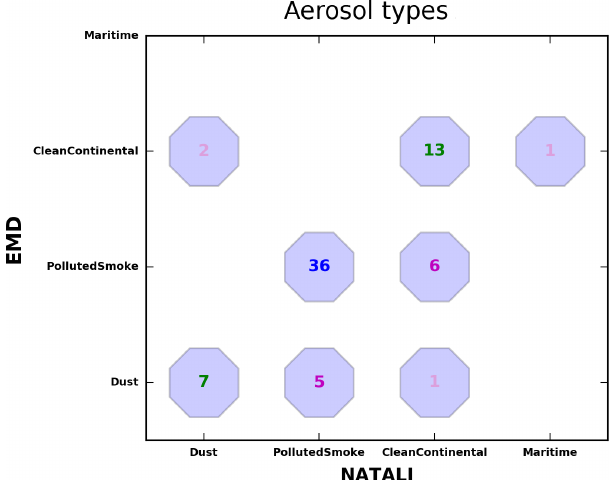
Figure 7. Number of cases per aerosol type derived by the two algo- rithms (EARLINET Mahalanobis distance-based typing algorithm – EMD and NATALI) for the period 2012–1015 (71